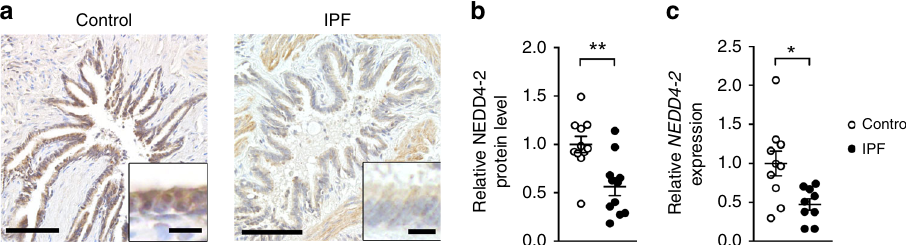
Fig. 1 NEDD4-2 expression is reduced in lung tissue biopsies from patients with IPF. a Micrographs of lung sections from patients with IPF and age- matched controls stained with anti-NEDD4-2 antibody (representative of n = 9/group). Scale bars, 100 and 10 µ m (insets). b , c Levels of NEDD4-2 protein as determined by parallel reaction monitoring mass spectrometry ( n = 11/group) ( b ) and NEDD4-2 mRNA (control, n = 10; IPF, n = 9) ( c ) in lung biopsies from IPF patients and controls. * P < 0.05, ** P < 0.01 compared to controls. Statistical analysis was performed with unpaired two-tailed t test. Data are shown as mean ± S.E.M. Source data are provided in the Source Data fi